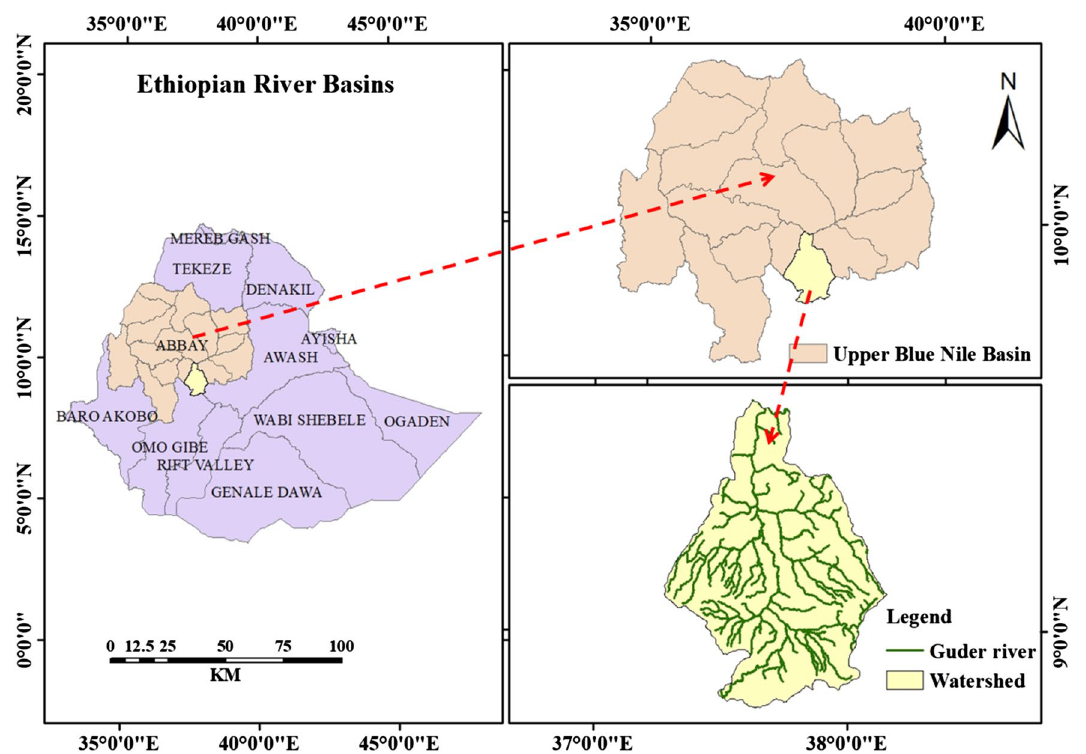
Fig. 1 Guder Sub-basin Map